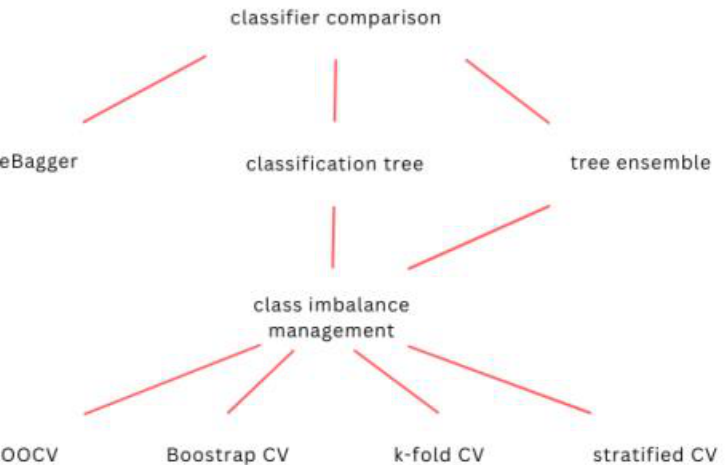
Figure 2. Flow chart of the experimental design. To classify astrocytes ’ morphology, we compared three classifier algorithms; we used methods to address class imbalance like RUSBoost and cost sensitive error functions. We also used four types of cross-validation.